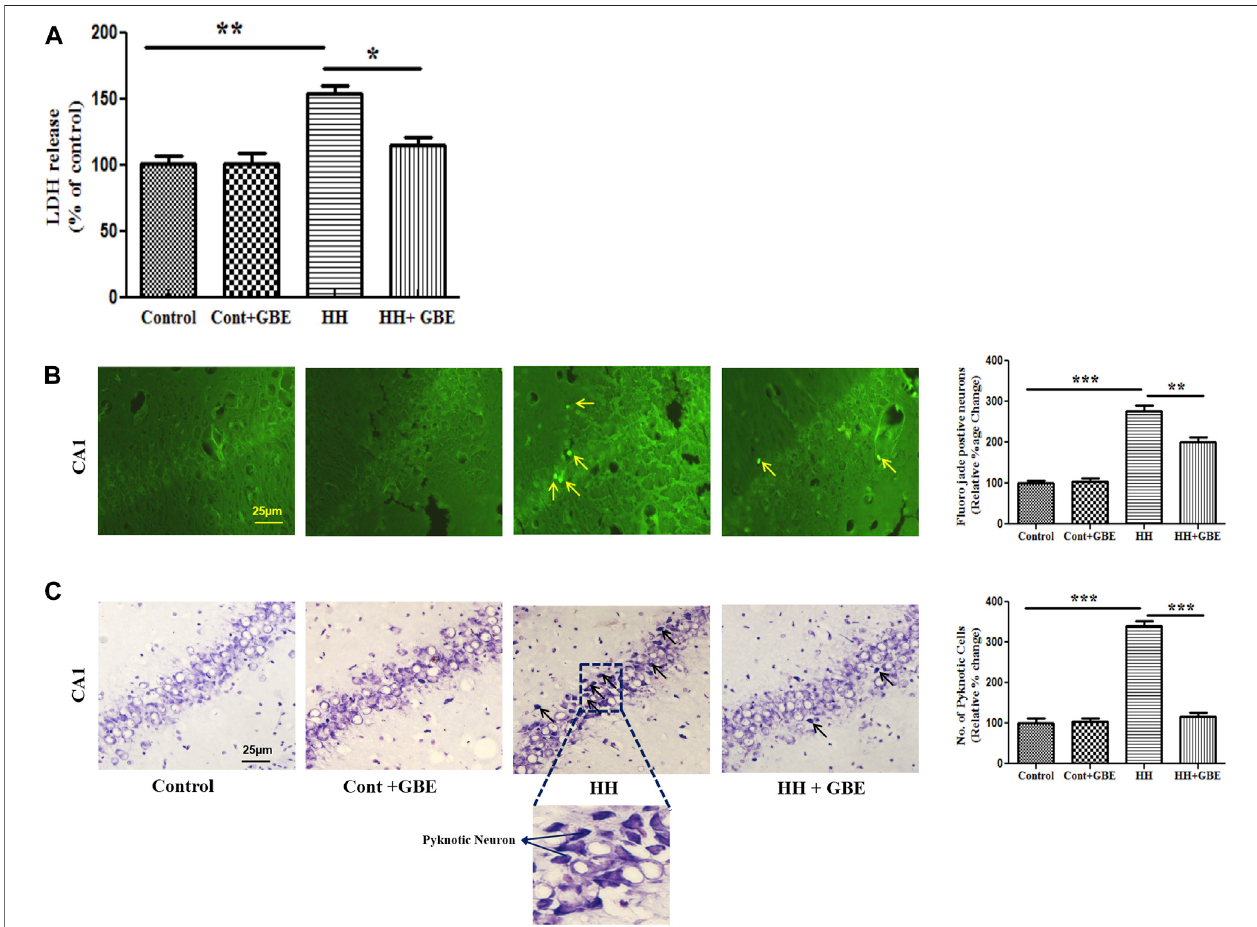
FIGURE 4 | GBE prevents LDH leakage and ameliorates neuronal damage and morphological alterations during HH exposure. Bar graph of LDH (A) that shows decreasedLDHreleaseafterGBEtreatmentwhichwasincreasedinHHexposure.HHleadstoneurodegenerationasevidentfromtheincreasednumberofFluoro-Jade B – positivecellsinthehippocampus.ImagesandbargraphshowanincreaseinFluoro-JadeB – positivecellsin14 daysofHHexposureascomparedtotheGBE-treated group which signi fi cantly reduced the Fluoro-Jade B – positive cells (B) . Cresyl violet staining was done to assess pyknotic cells which were higher in the HH group, whereas GBE signi fi cantly decreased the pyknotic cell count when compared to the HH group (C) . Black arrows indicate pyknotic cells. One-way ANOVA with the Bonferroni test was used to analyze the data. Data are represented as mean ± SEM. * p < 0.05, ** p < 0.01, and *** p < 0.001. The scale bar represents 25 µm.